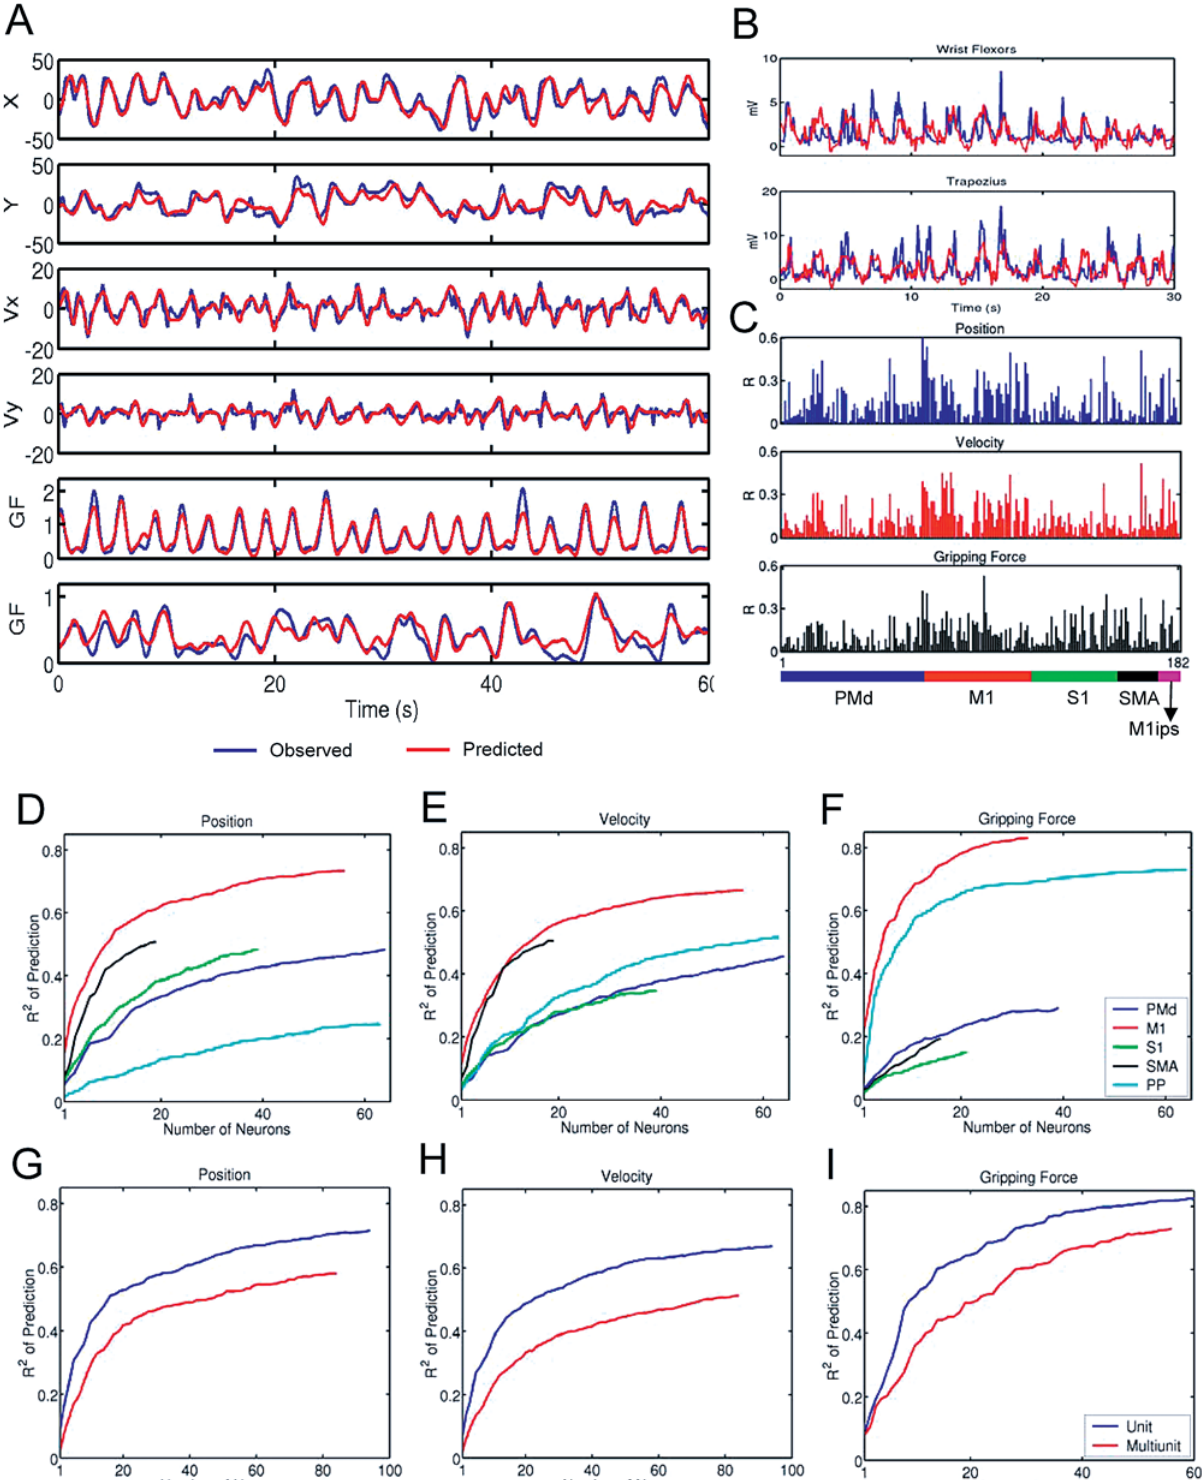
Figure 2. Performance of Linear Models in Predicting Multiple Parameters of Arm Movements, Gripping Force, and EMG from the Activity Frontoparietal Neuronal Ensembles Recorded in Pole Control (A) Motor parameters (blue) and their prediction using linear models (red). From top to bottom: Hand position (HPx, HPy) and velocity (HVx, HVy) during execution of task 1 and gripping force (GF) during execution of tasks 2 and 1. (B) EMGs (blue) recorded in task 1 and their prediction (red). (C) Contribution of neurons from the same ensemble to predictions of hand position (top), velocity (middle), and gripping force (bottom). Contributions were measured as correlation coefficients ( R ) between the recorded motor parameters and their values predicted by the linear